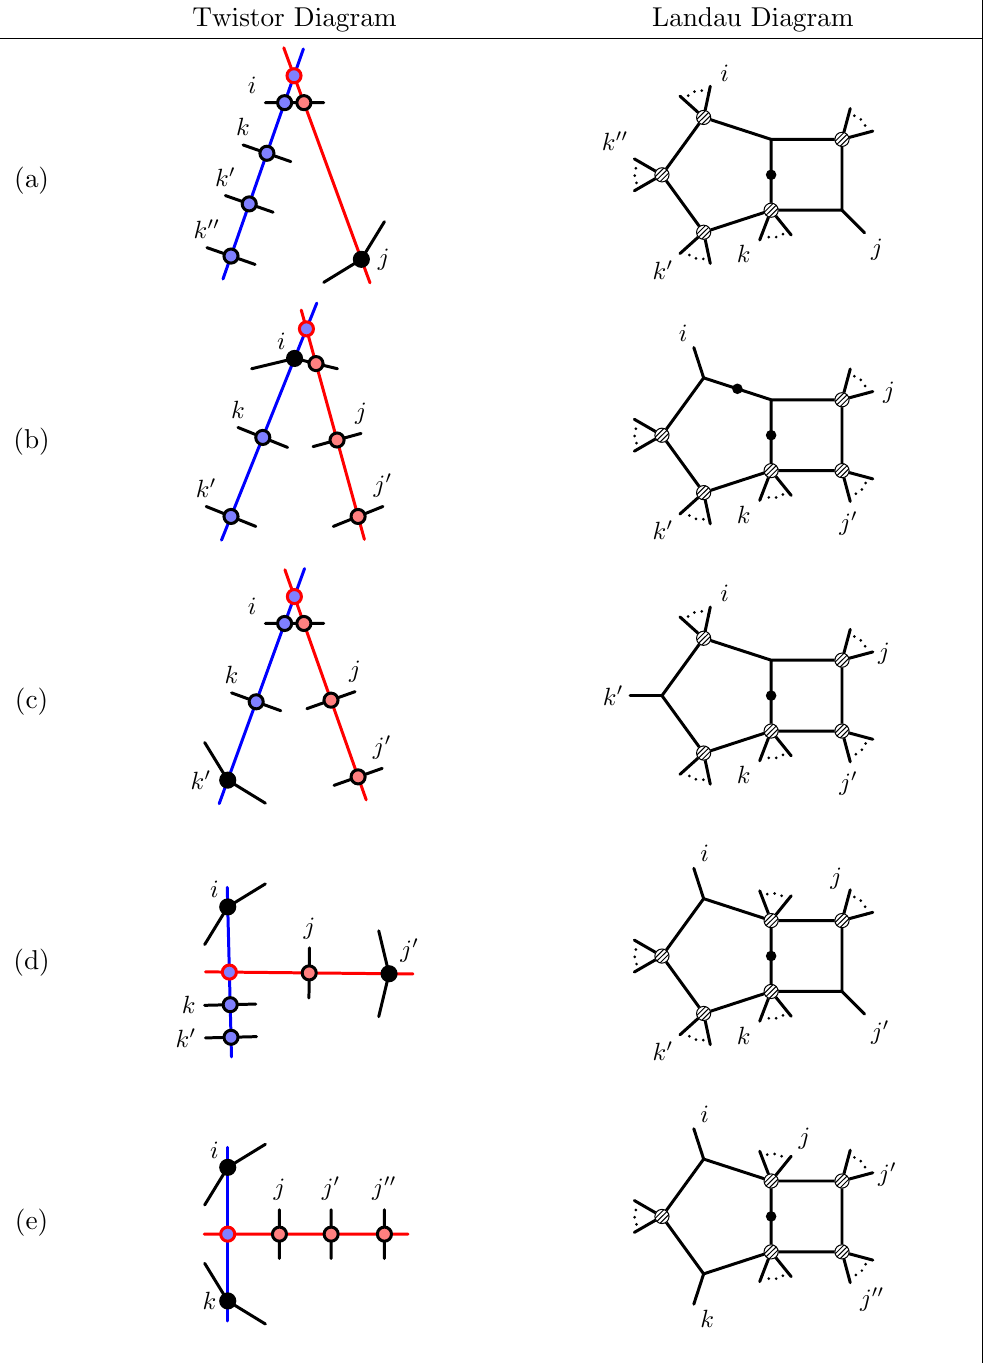
Table 3 . The twistor and Landau diagrams describing types of (resolved, in (b)) maximal codi- mension boundaries of N k (cid:21) 2 MHV